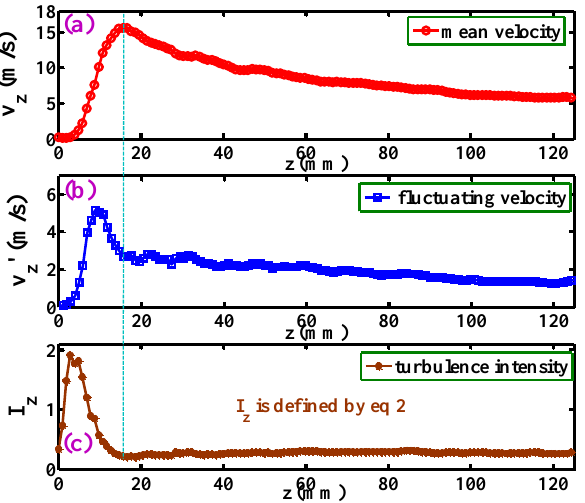
Figure 8. Development of ( a ) the mean velocity, v z , ( b ) the fluctuating velocity, v z ’, and ( c ) the turbulence intensity, I z , along the centerline.